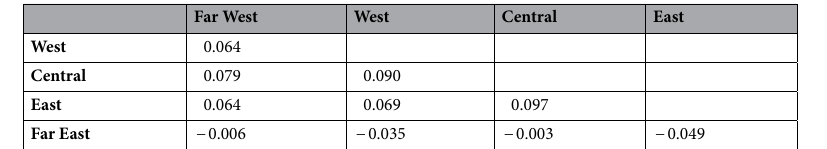
Table 2. Pairwise F ST values among five geographic clusters in Canada for S. famelica and S. eriocephala identified by Bayesian analysis.